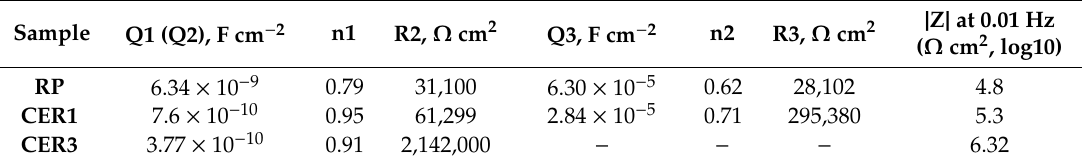
Table 7. Data of EIS results from the equivalent circuits which were obtained from EC Lab Fitting Software for RP, CER1, and CER3 after immersion in 3.5% NaCl solution for 4